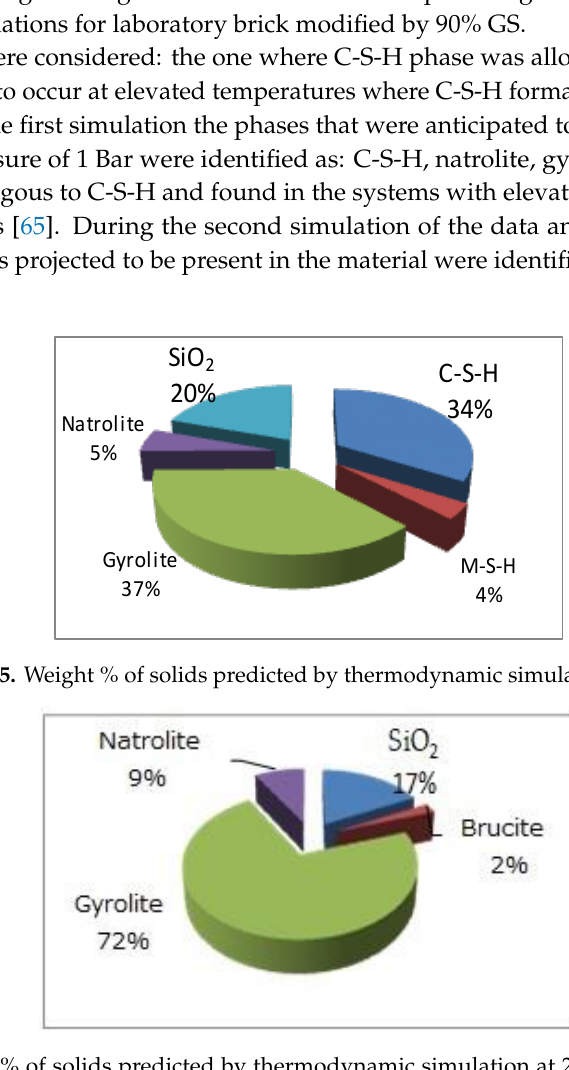
Table 6. Thermodynamic (geochemical modeling, GEMS) simulation results obtained at 20 °C.